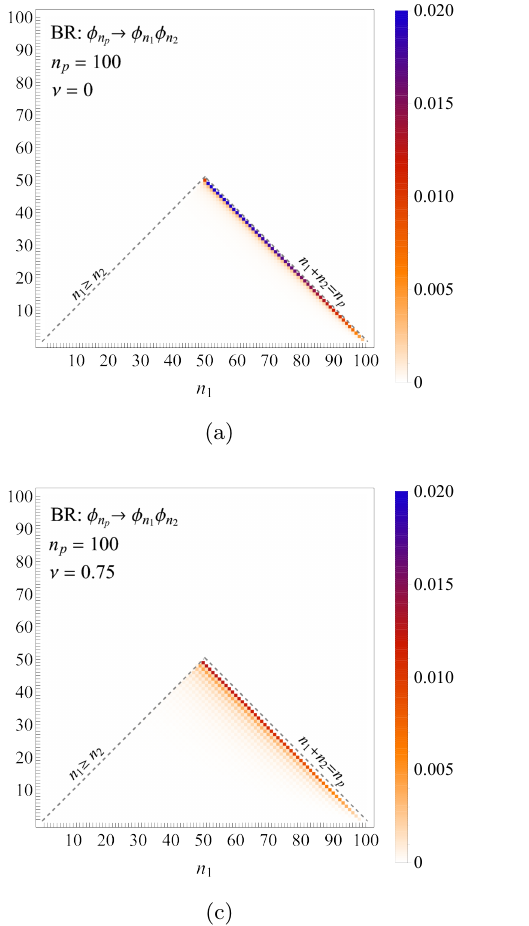
. Dominant 1 ≥ n 2 = n line is shown in (d), where the 1 2